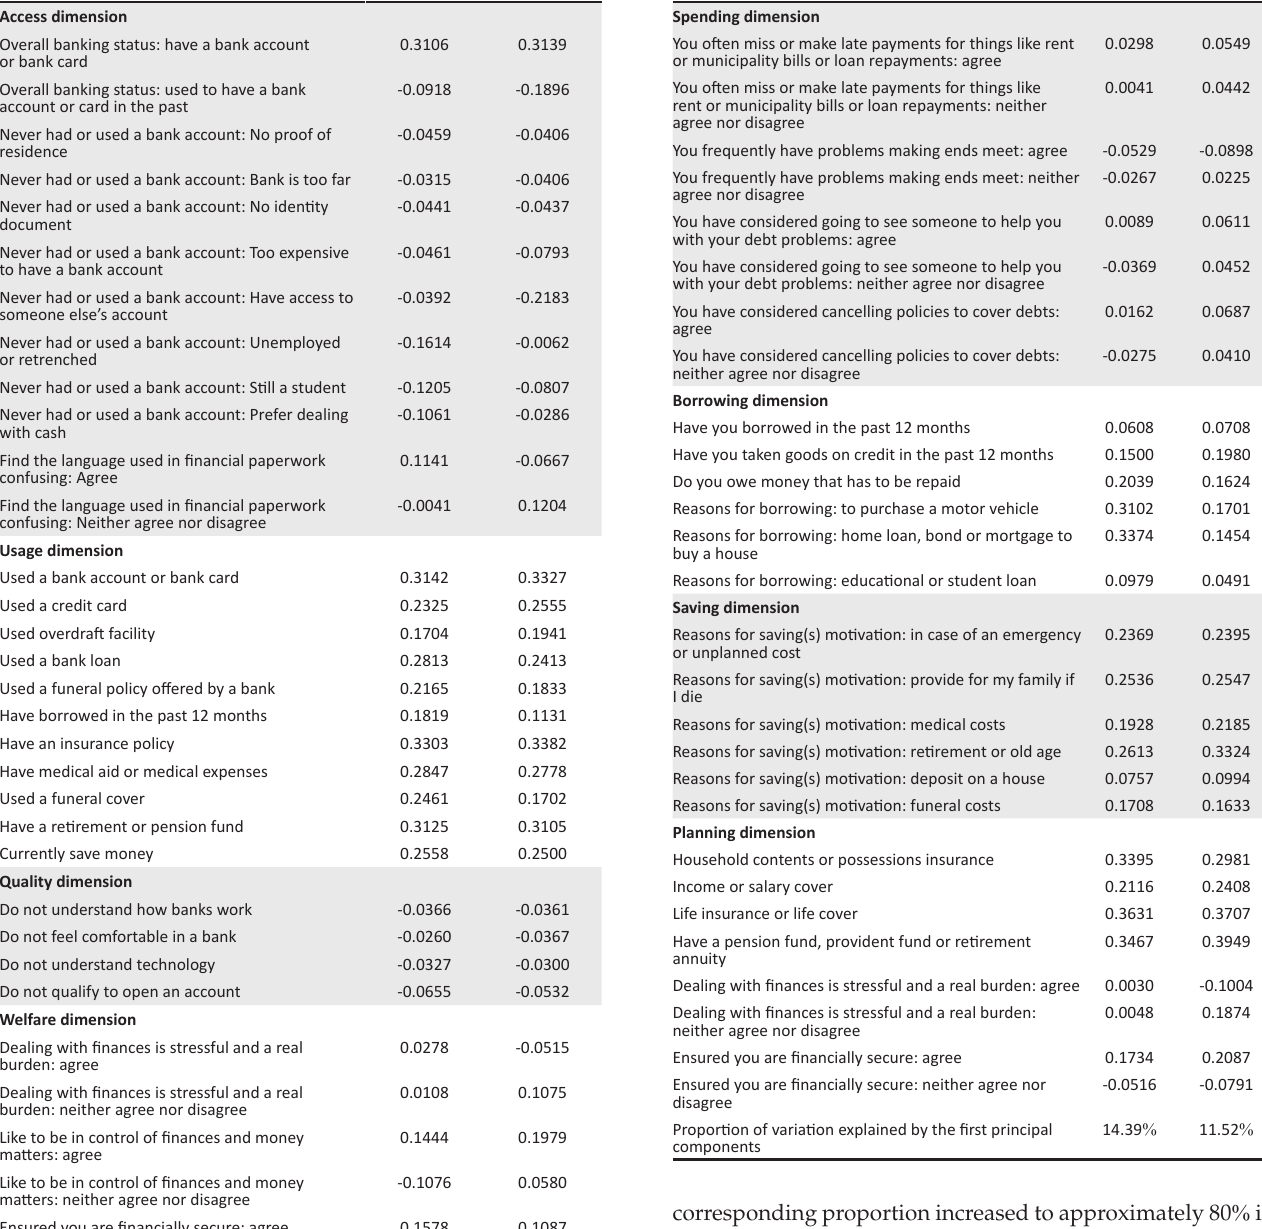
TABLE 2: First principal components for deriving the financial inclusion index. Dimension